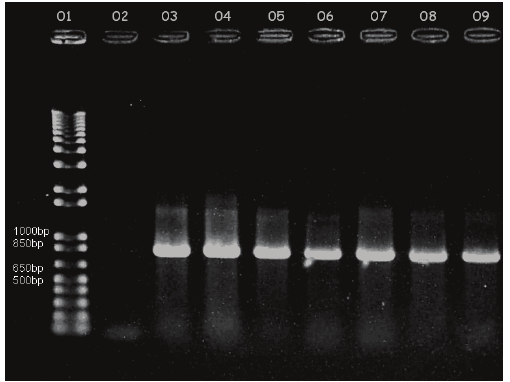
FIGURE 1 - Amplification of the 815bp eae gene from different enteropathogenic Escherichia coli strains on 0.8% agarose gel. 01: Base pair marker 1 kb Plus (Invitrogen). 02: Negative control (without DNA). 03: Strain 008. 04: Strain SPA14. 05: Strain SPA16. 06: Strain HE8. 07: Strain 4225. 08: Strain 3549. 09: Strain 4083. i - Dose: 10mg/Kg Endal Plus (Shering-Plough)